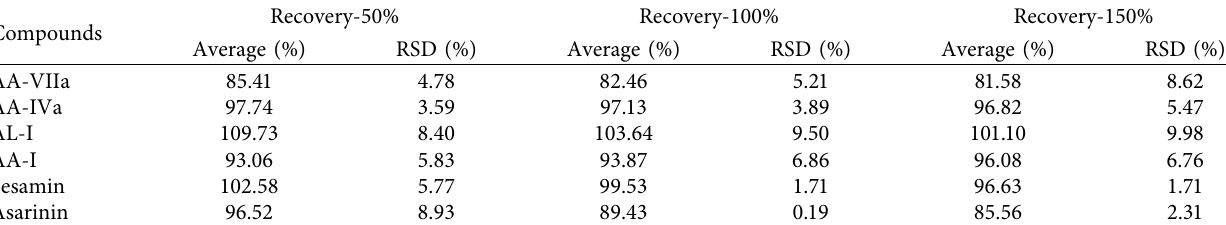
Table 5: The recovery result of the analytes ( n � 3).